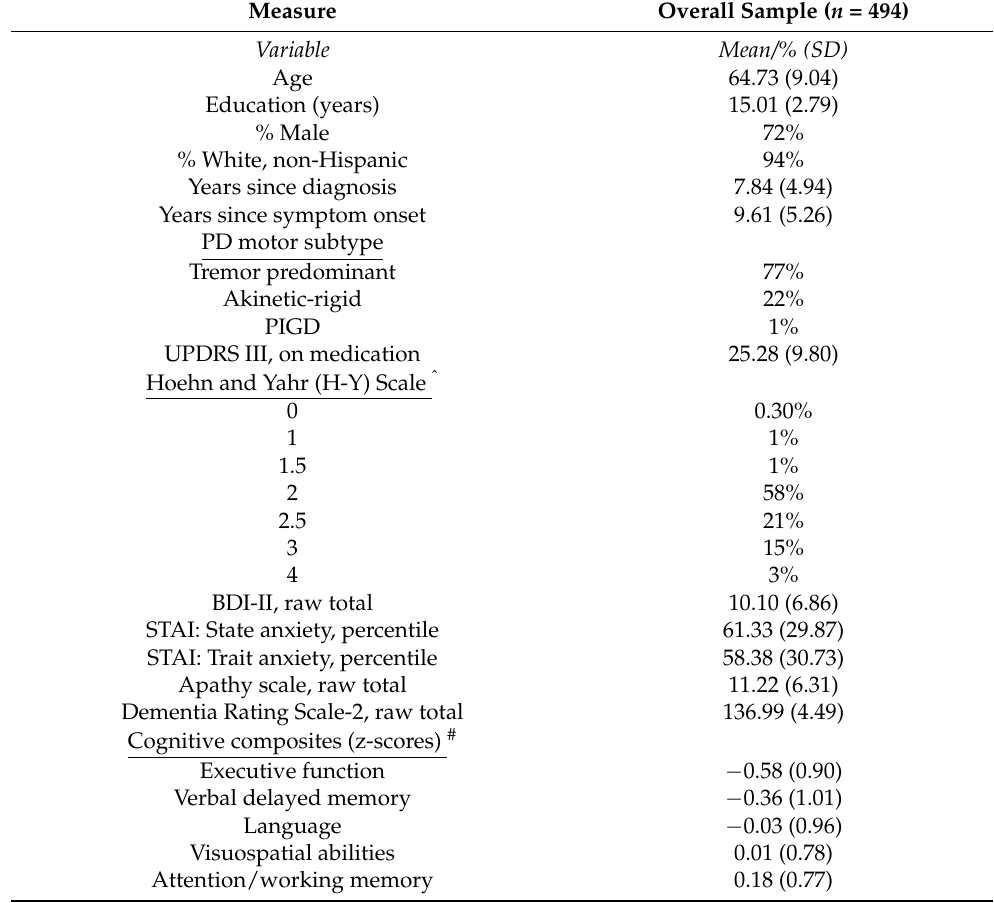
Table 2. Sample Descriptive